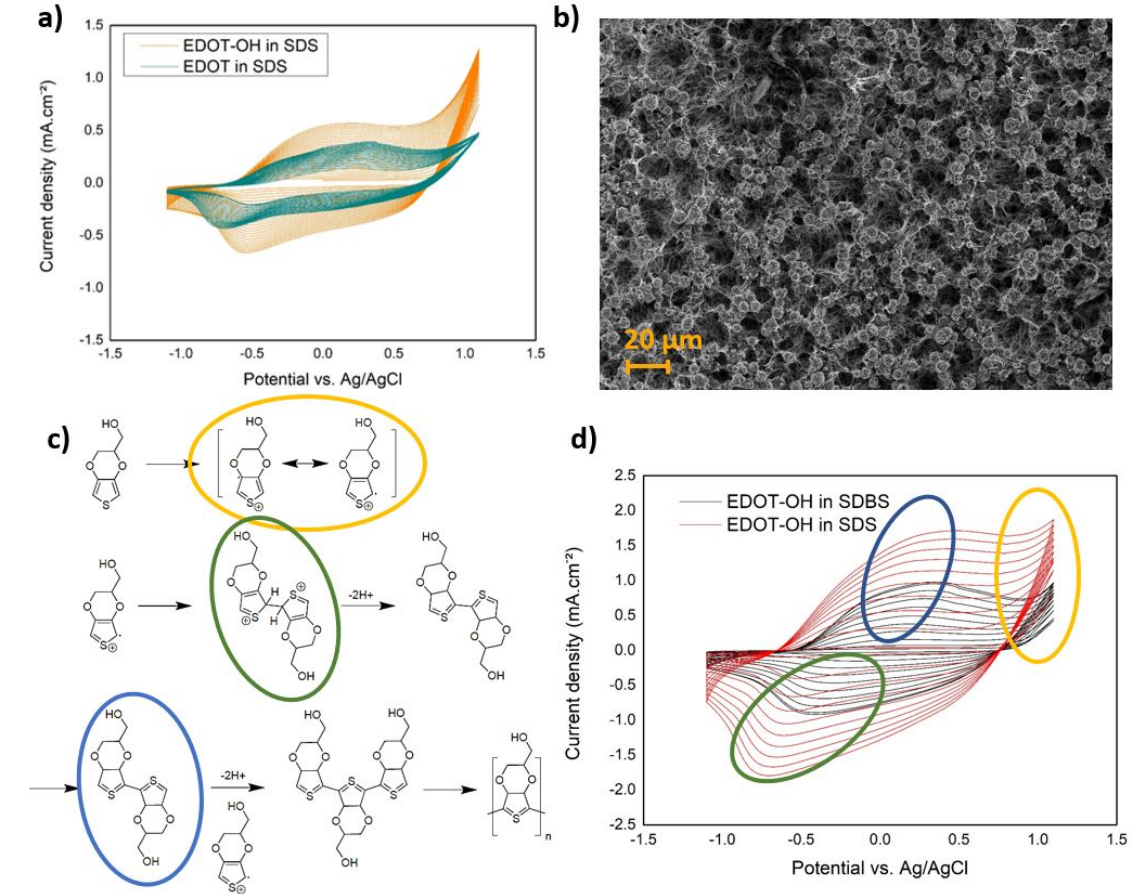
Figure 1. Nanocomposite electrode formulation, with ( a ) the electropolymerization comparison of EDOT and EDOT-OH, ( b ) the SEM top view of the PEDOT-OH-Al 3 @SiNWs nanocomposite electrode, ( c ) electropolymerization mechanism described and main deposition steps specified on the CV curves, with circled in yellow the polaronic form, circled in green the dimerization, circled in blue the propagation of the phenomenon and deposition of polymer EDOT-OH ( d ) comparison of surfactants SDS and SDBS in electrodeposition of EDOT-OH at 50 mV·s − 1 , critical micellar media (0.01 M).